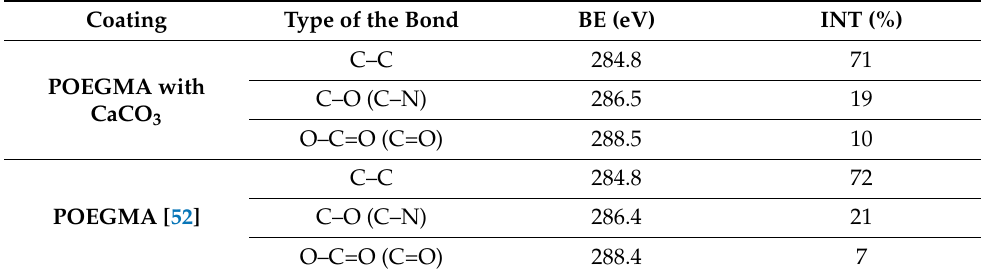
Figure 3. Ca 2p XPS spectra of POEGMA-grafted brush coating with embedded CaCO 3 (Ca 2p 3/2 line position 347.2 eV, multiplet splitting 3.67 eV). Table 1. Relative Intensities of C–C, C–O (C–N), and O–C=O signals.